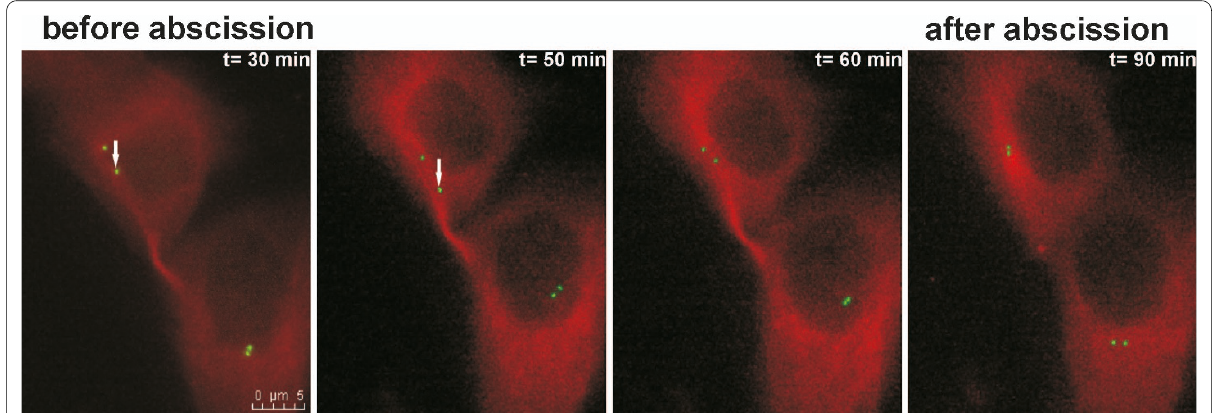
Figure 3 Centrioles migrate occasionally towards the intercellular bridge during cytokinesis in human epithelial cells . Representative images